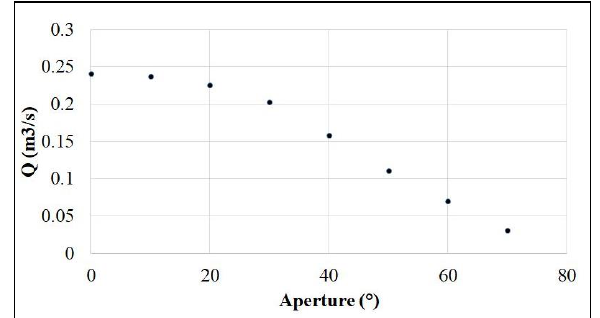
Fig. 18. The experimental line verification measurement result – the flow.